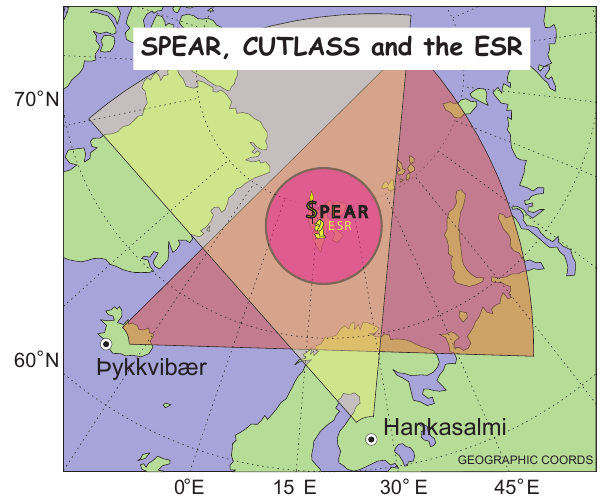
Fig. 4. Map of the locations of SPEAR, CUTLASS and ESR to- gether with the CUTLASS Finland and Iceland radar fields of view. Fig 4 The pink circle represents the typical spatial coverage of ESR mea-